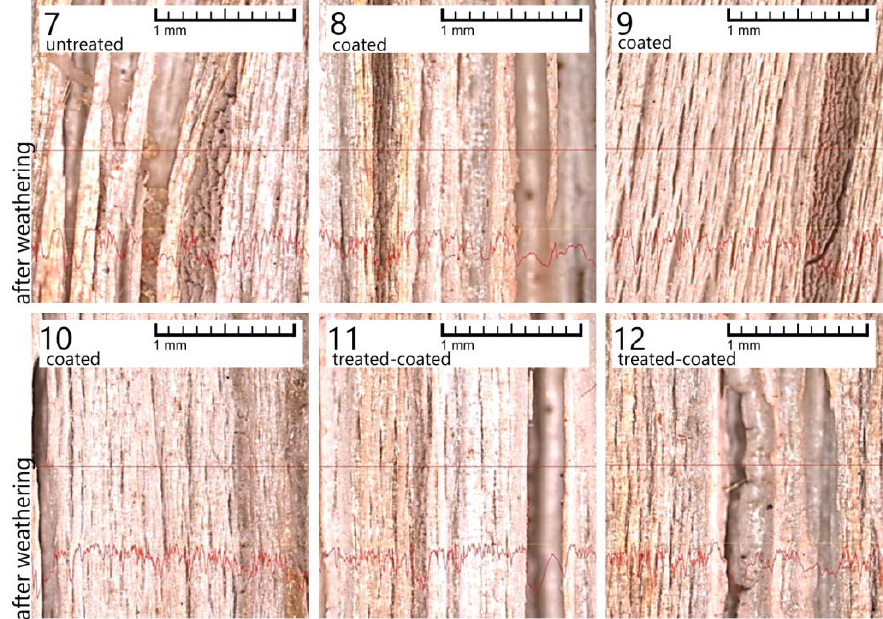
Figure 4. Samples after 6 weeks of artificial weathering (6 weeks); reference untreated oak ( 7 ); oak treated with hydrophobic coating A ( 8 ); oak treated with hydrophobic coating B ( 9 ); oak treated with oil based coating C ( 10 ); oak with surface modification No. 3 and hydrophobic coating A ( 11 ); oak with surface modification No. 4 and hydrophobic coating B ( 12 ). Visible degradation of tested coatings, opening of oak vessels, and creation of micro-cracks and cracks on all tested surfaces . Using only hydrophobic coatings does not cause a significant increase in the gloss of the underlying wood (Figure 5). Unlike the oil coatings (C), hydrophobic coatings do not change the